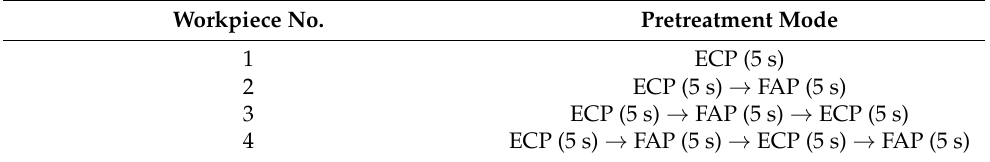
Table 5. Pretreatment methods used in EIS measurements. Workpiece No.